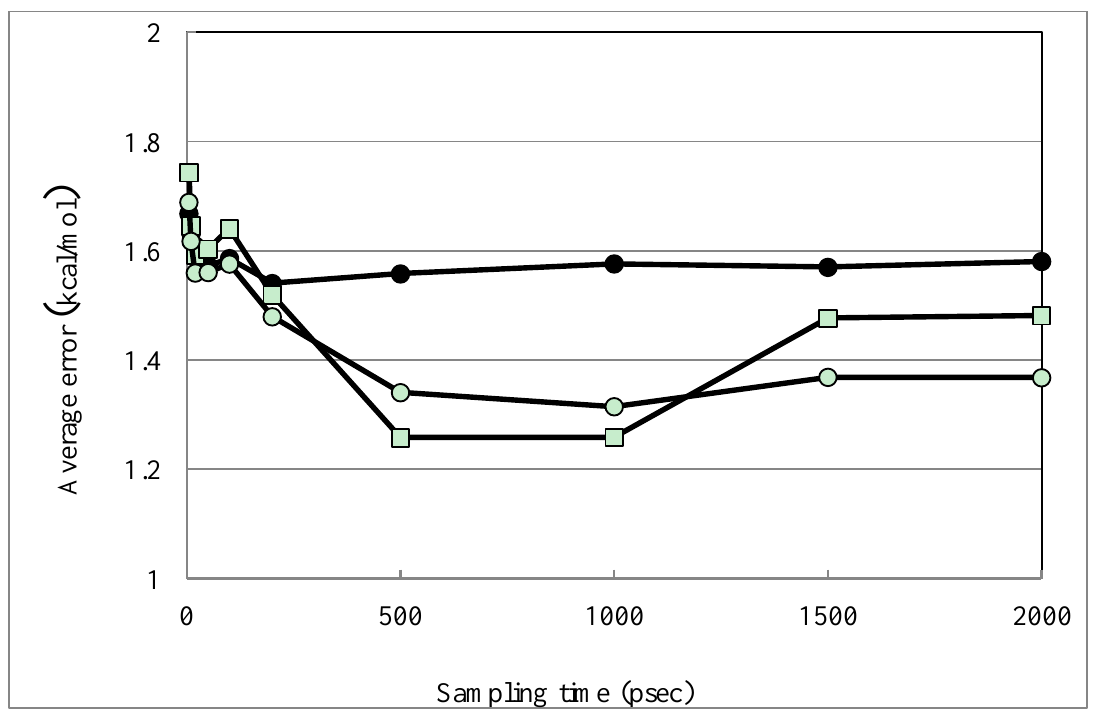
Figure 2. Time dependence of the DIAV, DIAV_LW and DIAV_LC results. Filled circles, open squares and open circles represent the results obtained by the DIAV, DIAV_LW and DIAV_LC methods, respectively. The averaged error is plotted vs. the sampling-time